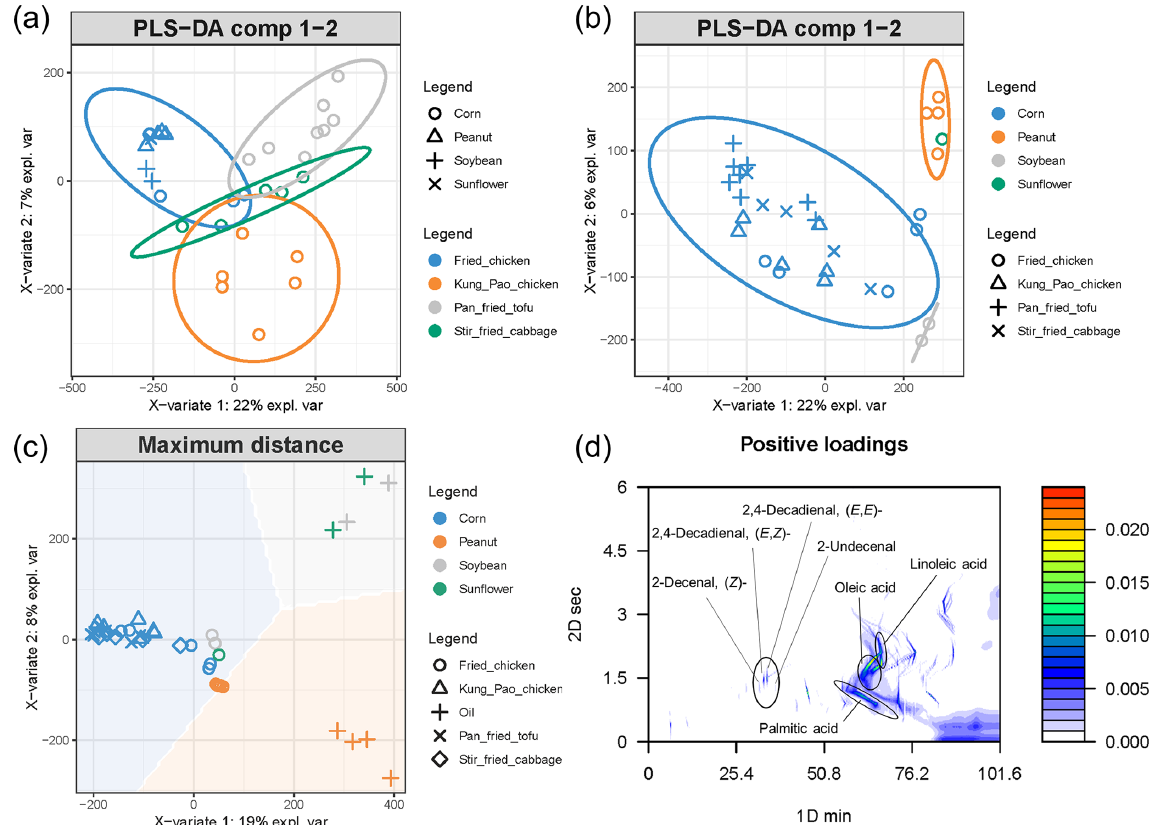
Figure 5. PLS-DA classification results in setting the cooking style (a) or oil (b) as grouping variables. When oil was set as the grouping variable, the separation of groups was much better than setting the dish as the grouping variable. The PLS-DA comparison result of cooking emissions and oils is displayed in (c) , indicating that the cooking fume is not just the evaporation of oil itself. Positive loadings of oil and cooking fume chromatograms (d) demonstrated the key components contributing to the similarities of